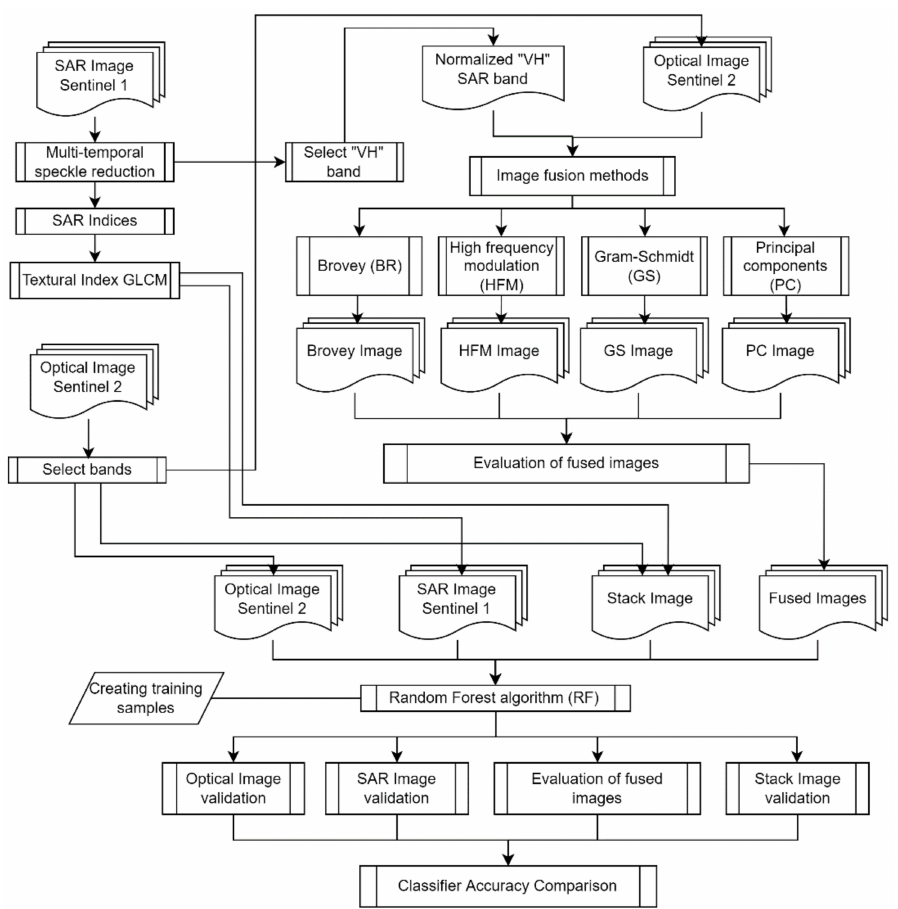
Figure 2. Overall workflow used in this study describing the pre-processing, image fusion process, and land cover classification